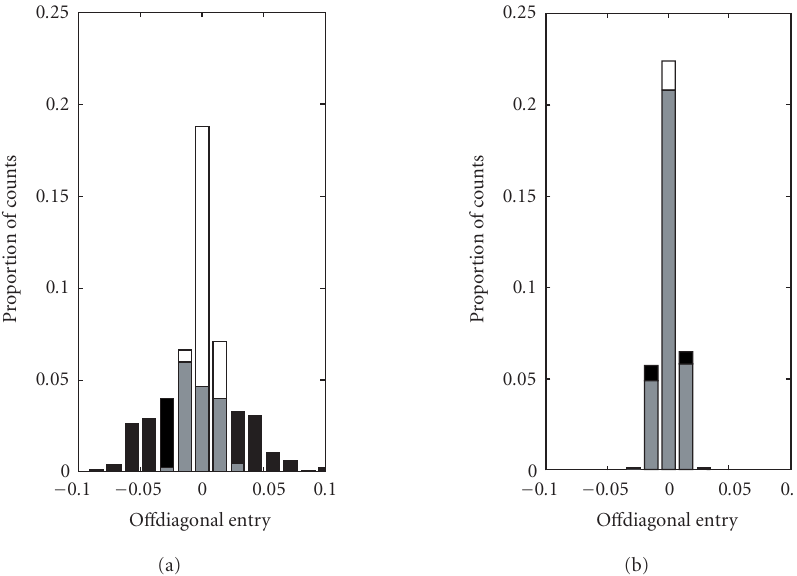
Figure 6: Histograms of the o ff diagonal term of I , defined in (22), corresponding to the residual corruption of “CMB” by “dust” while separating Gaussian maps generated with the same power spectra as the astrophysical components, by joint diagonalization of covariance matrices in (a) Fourier and (b) wavelet spaces, with (black, which appears grey when seen through white ) and without (white) masking part of the data. The dark widest histogram on the left highlights the impact of masking on source separation based on Fourier covariance matrices.